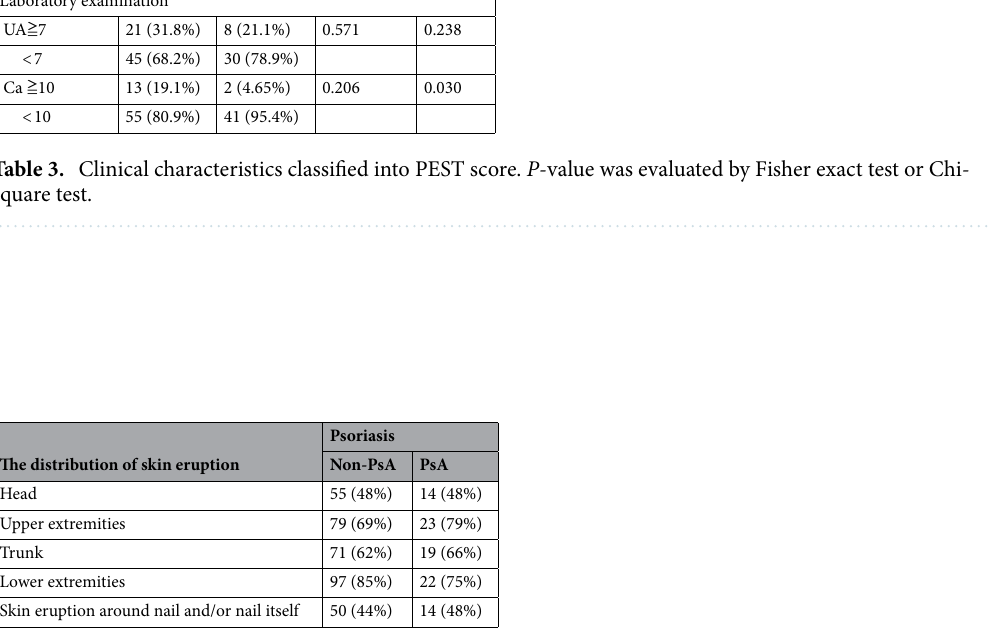
Table 4. The skin distribution based on PEST score. There is some overlapping in the distribution of arthritis.